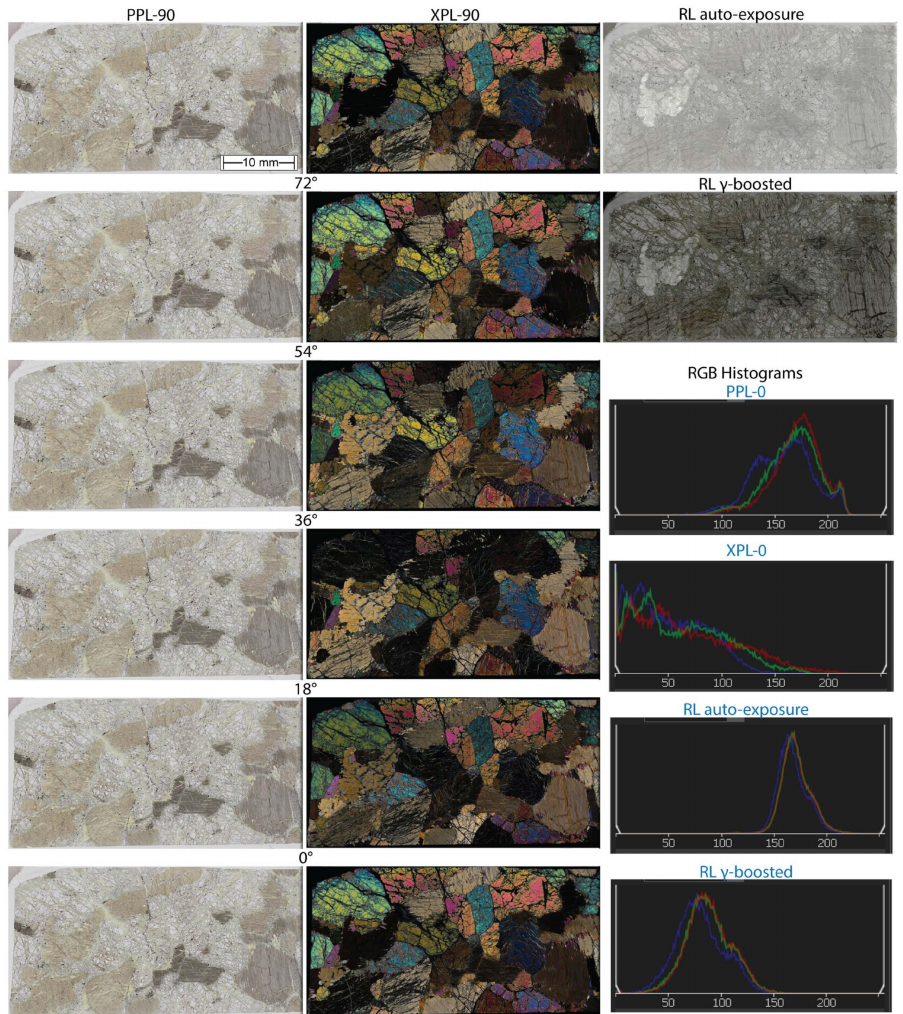
Figure 4. Whole-slide images in plane polarized (PPL) ( left ) and cross-polarized light (XPL) ( centre ) in multi-angle polarisation showing 18 ◦ steps of slight pleochroism and vivid interference colours of a coarse-grained harzburgite with olivine, pyroxene (ol > opx > cpx), spinel, and alteration products. Two unpolarised reflected light (RL) images ( top-right ) are obtained, one with standard illumination and the other with the gamma value boosted ( second on the top-right ). This allows us to better distinguish different silicates in RL, as seen in the histograms ( bottom-right ). Sample ID: